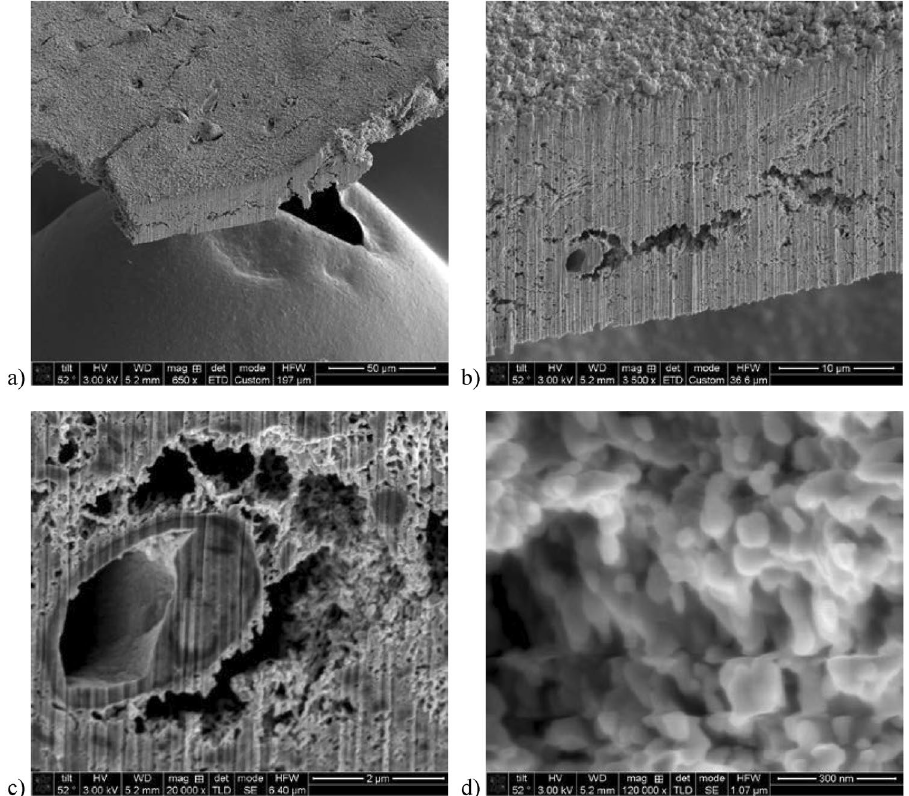
Figure 4. SEM micrographs of brain tissue sample after SiS ZnO treatment and after a slice was milled off using focused ion beam. Vertical striations are artifacts from the ion beam milling procedure. ( a ) SEM micrograph image at 650 X. Scale bar is 50 μ m. ( b ) SEM micrograph image at 3.5 K X. Scale bar is 10 μ m. ( c ) SEM micrograph image of a sliced putative cell (neuron) at 20 KX. Scale bar is 2 μ m. ( d ) Image taken at one of the smaller cavities above the putative cell (neuron) seen in ( c ) at 120 KX. Scale bar is 300